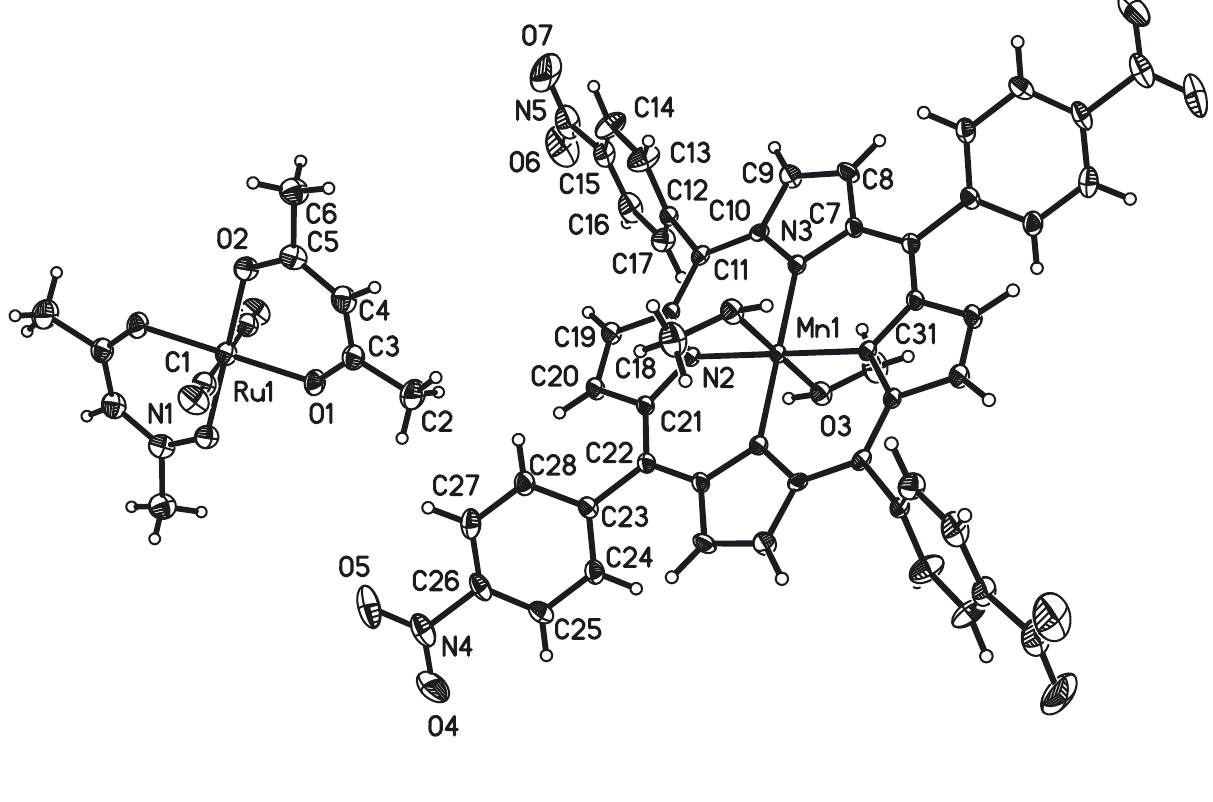
Table 1 contains crystallographic data and Table 2 contains the list of the atoms including atomic coordinates and displacement